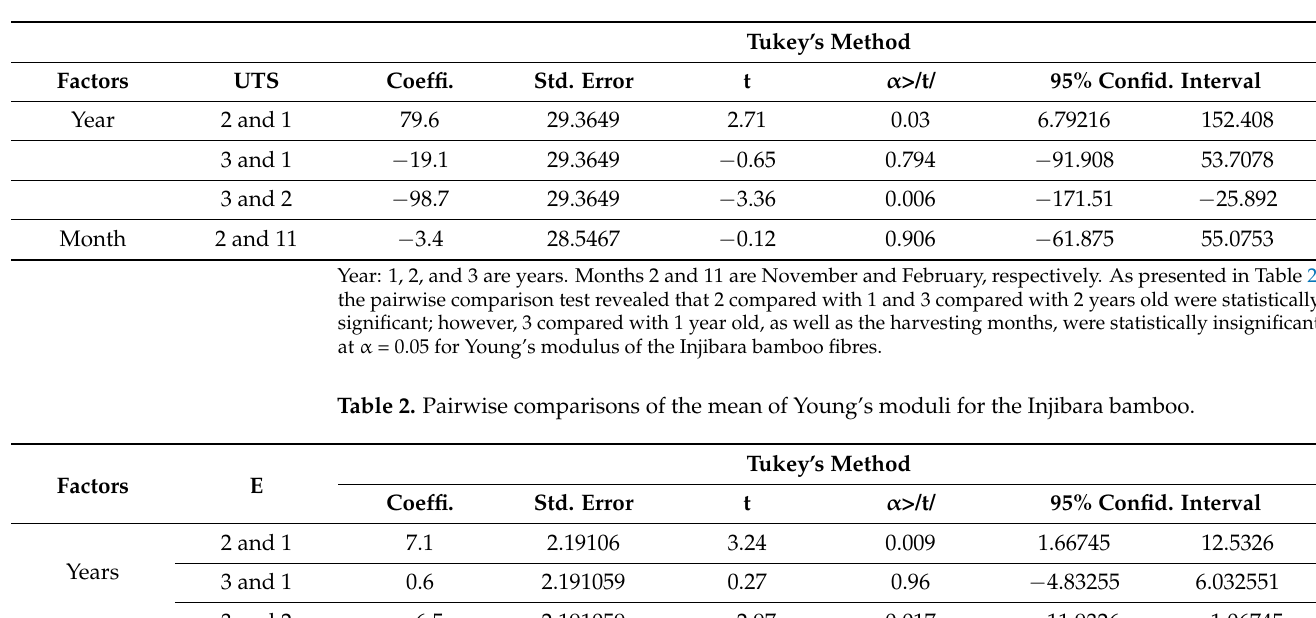
Figure 9. Ultimate tensile strengths of the bamboo fibres epoxy composites. Table 1. Pairwise comparisons of the mean of the tensile strength for Injibara bamboo.